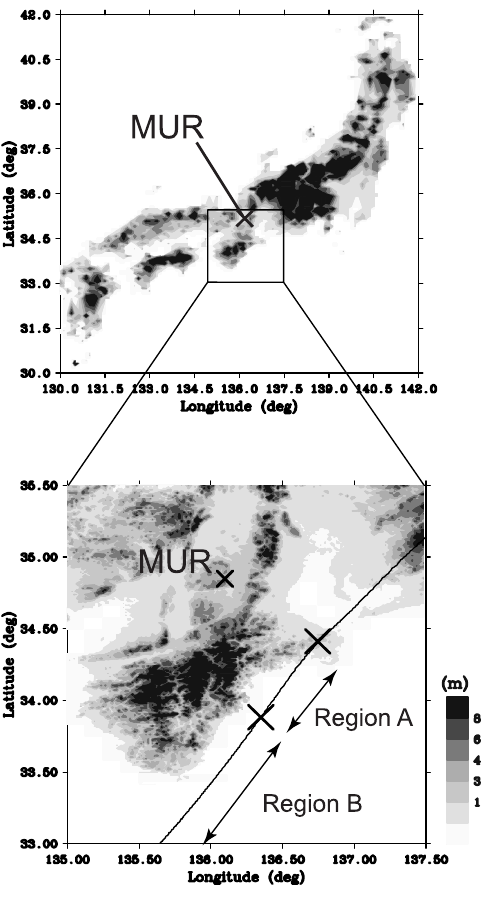
Fig. 7. Topographical map around the MU radar site. iform, convective, and mixed stratiform-convective precipi- tating clouds by using the vertical velocity and the reflectiv- ity obtained from the MU radar and the C-band radar, respec- tively. In the stratiform precipitating cloud, a vertical shear of radial winds and the maximum speed of counterclockwise winds were observed. There was a prominent bright band around the 4 km altitude, which corresponds to a relatively dry layer. Strong updrafts and downdrafts were seen above and below it, respectively. In the convective precipitating cloud, the regions of strong and weak reflectivities were well associated with those of updraft and downdraft, respectively.